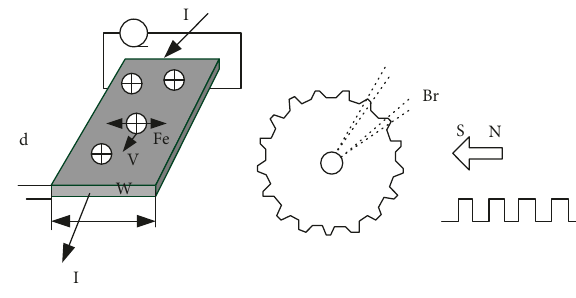
Figure 4: Testing principle of Hall